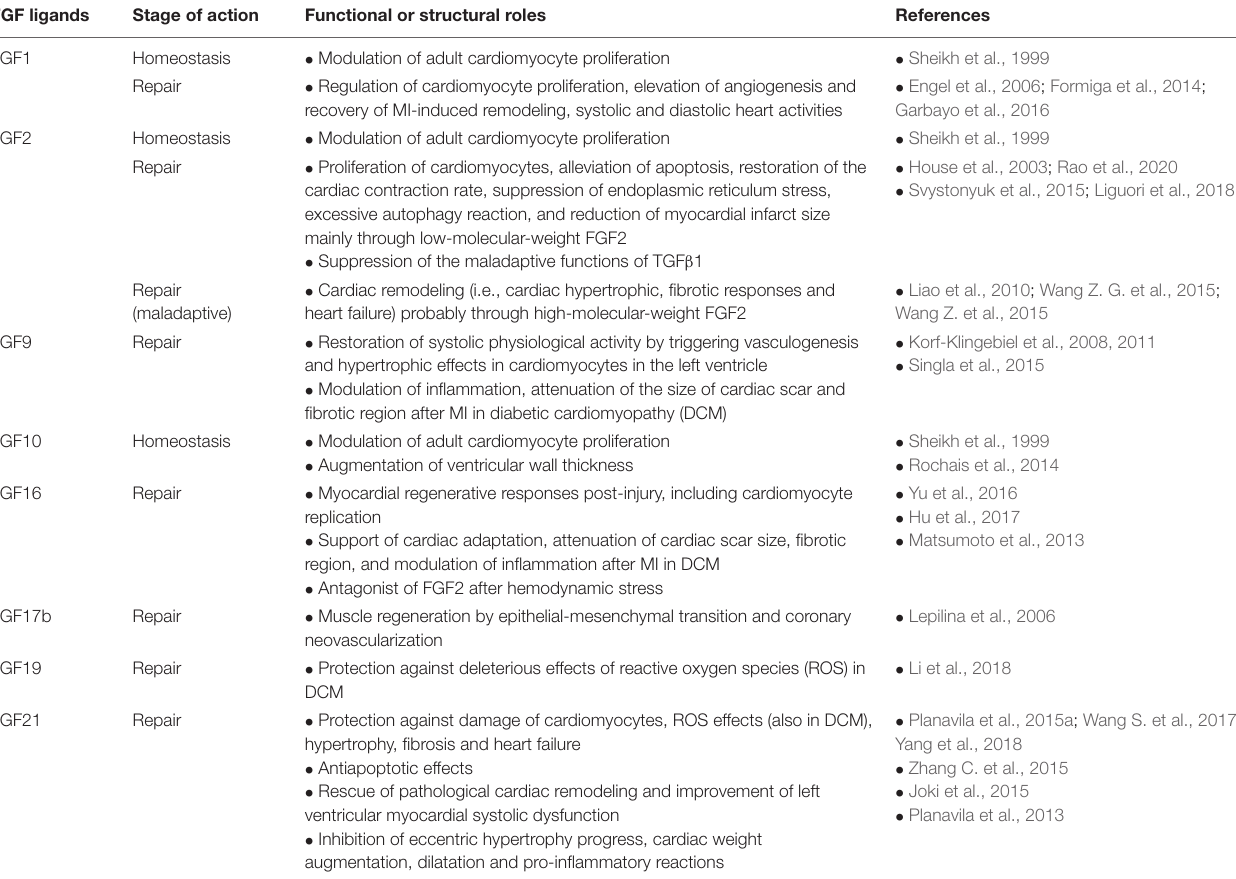
TABLE 2 | Cardioprotective and maladaptive effects of secreted FGFs on homeostasis and repair of heart detected in experimental injury models. FGF